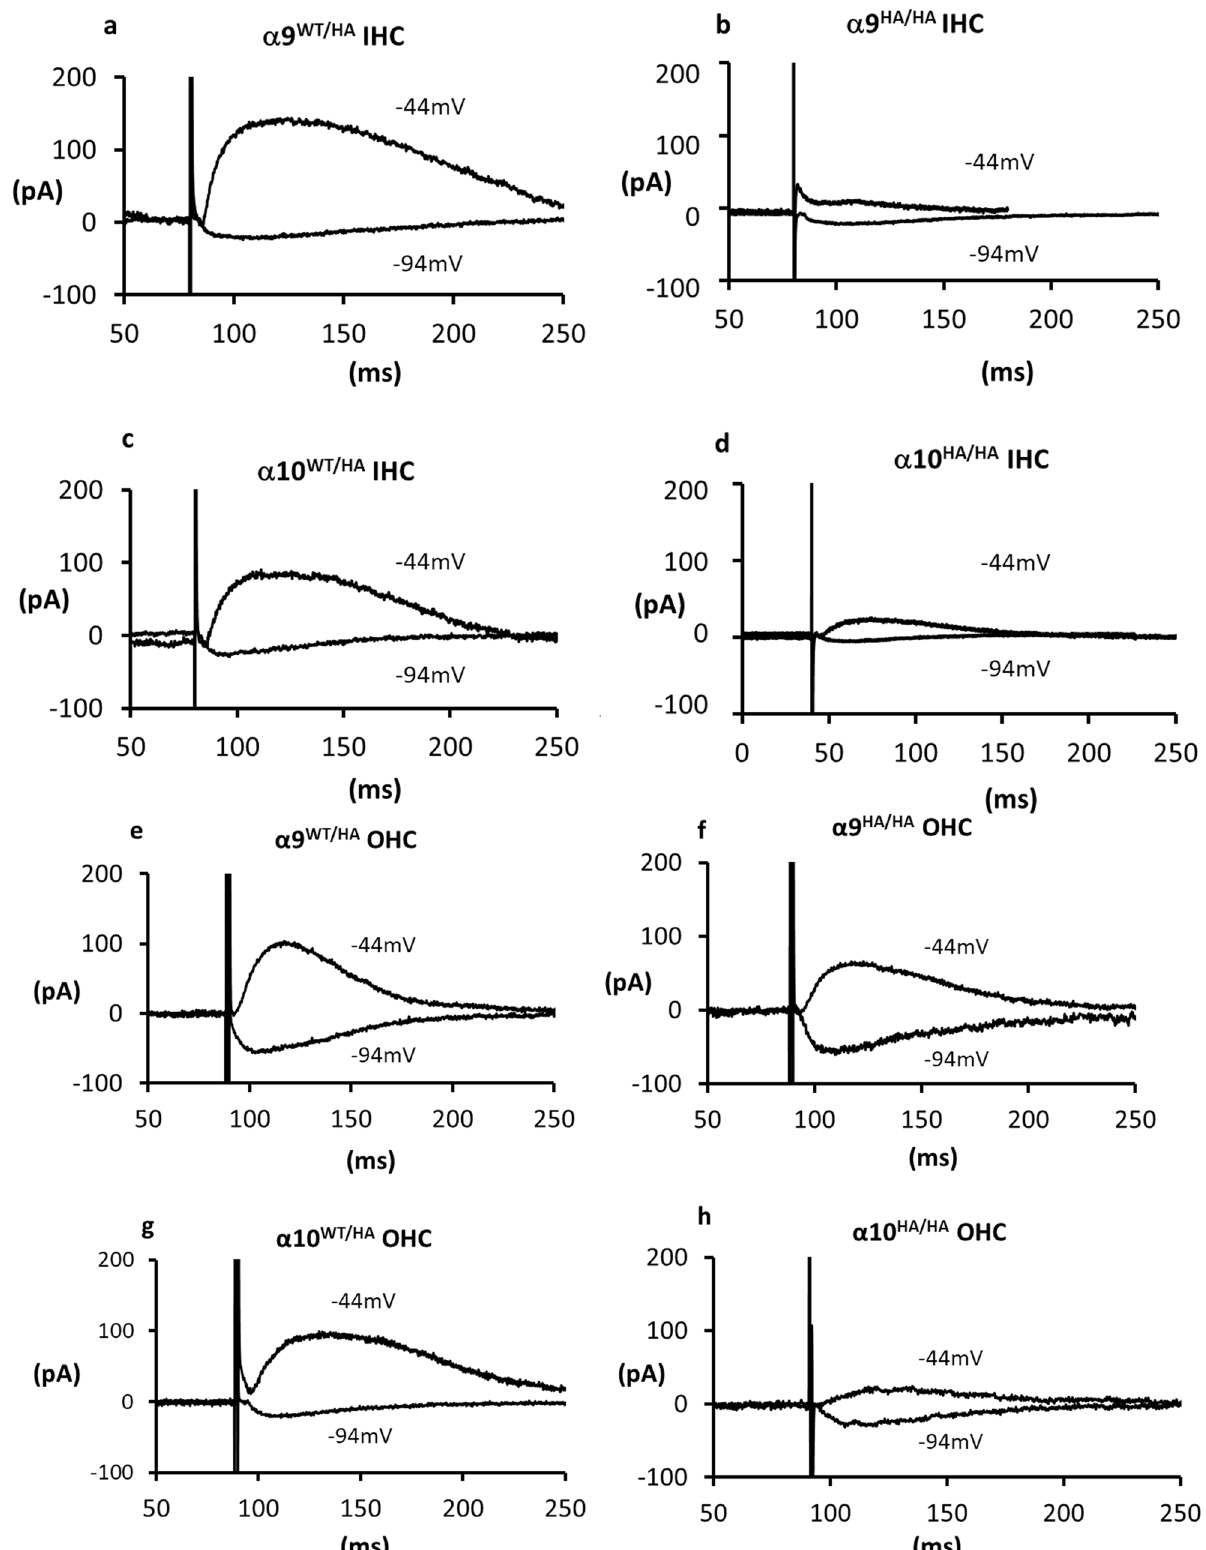
Figure 8. Efferent synaptic currents in inner hair cells (IHCs) and outer hair cells (OHCs). Average waveform of successes during 1 Hz stimulus train (vertical line is the shock artifact). Outward current and inward current from IHCs are shown here for different genotypes—α9 HA/WT ( a ), α9 HA/HA ( b ), α10 HA/WT ( c ) and α10 HA/HA ( d ). Outward current and inward current from OHCs in different genotypes are shown here—α9 HA/WT ( e ), α9 HA/HA ( f ), α10 HA/WT ( g ) and α10 HA/HA ( h ). Hair cell membrane potentials are indicated for each recording. Baseline subtracted from all records for direct comparison of waveform. All recordings were performed at postnatal ages